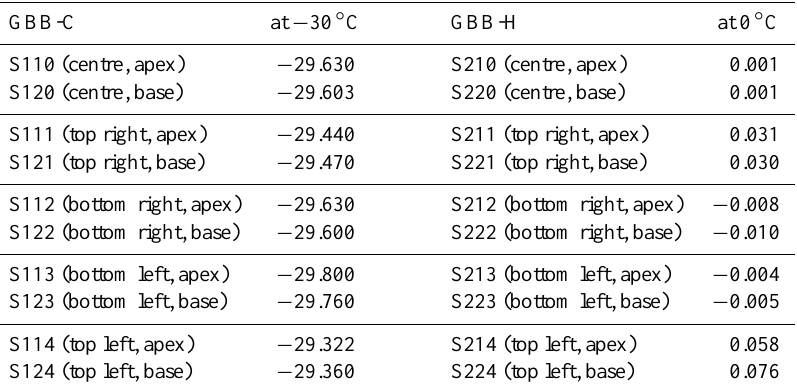
Table 5. Radiance temperature measurements of the GBB optical surface at − 30 ◦ C for GBB-C and at 0 ◦ C for GBB-H, respectively. Measurement positions are given in Fig. 6. GBB-C at − 30 ◦ C GBB-H at 0 ◦ C S110 (centre, apex) − 29.630 S210 (centre, apex) 0.001 S120 (centre, base) − 29.603 S220 (centre, base) 0.001 S111 (top right, apex) − 29.440 S211 (top right, apex) 0.031 S121 (top right, base) − 29.470 S221 (top right, base) 0.030 S112 (bottom right, apex) − 29.630 S212 (bottom right, apex) − 0.008 S122 (bottom right, base) − 29.600 S222 (bottom right, base) − 0.010 S113 (bottom left, apex) − 29.800 S213 (bottom left, apex) − 0.004 S123 (bottom left, base) − 29.760 S223 (bottom left, base) − 0.005 S114 (top left, apex) − 29.322 S214 (top left, apex) 0.058 S124 (top left, base) − 29.360 S224 (top left, base)